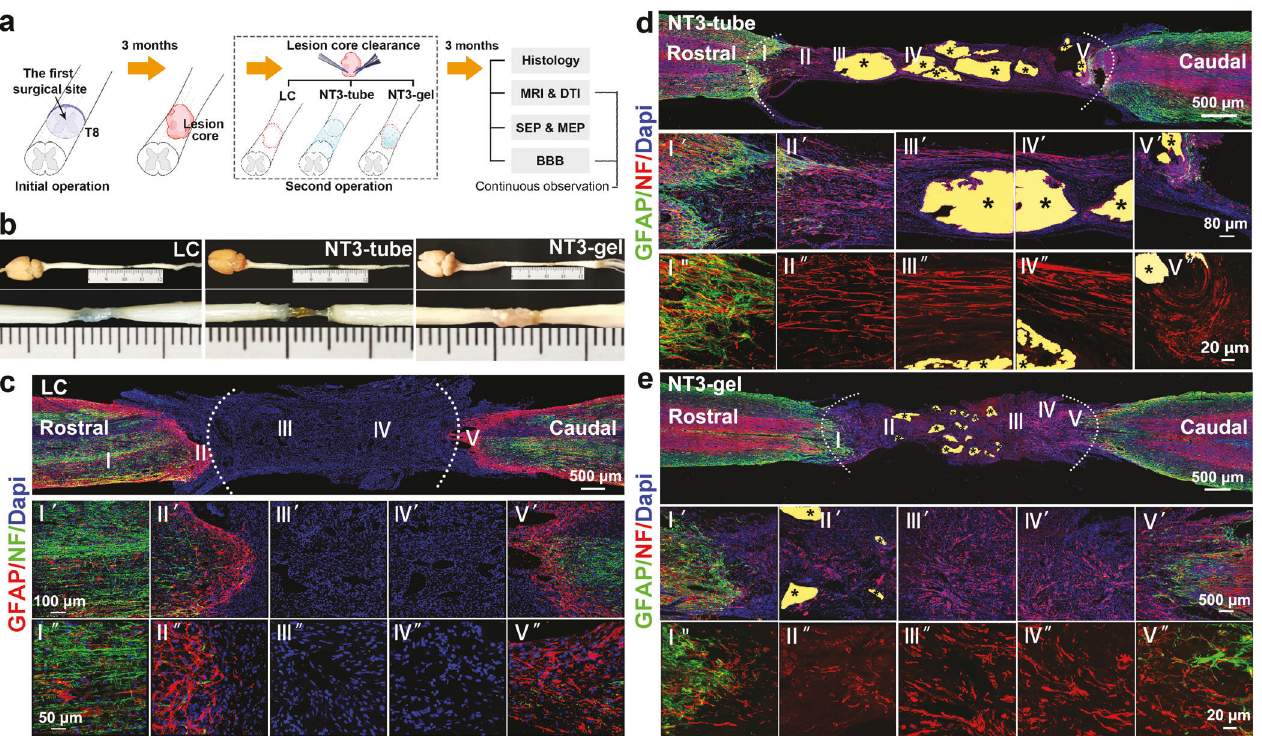
Fig. 2 NT3-chitosan promoted endogenous neurogenesis in lesion area after SCI. a Schematic diagram of the experimental procedure. b Dorsal view of representative spinal cords from three treatment groups: the NT3-tube group, NT3-gel group, and LC group at 3 mo after the second operation. c – e Immunographs of NF and GFAP-positive cells in the injured/regenerating nerve tissues of LC, NT3-tube, and NT3-gel groups at 3 mo after the second operation. No NF-positive (red) Nerve fi bers were found in LC groups ( c ). A mass of neuro fi lament staining (red) detected in regenerated neural tissues with NT3-tube ( d ) and NT3-gel ( e ) groups. *Labels undegraded chitosan biomaterials. Serially ampli fi ed images of highlighted